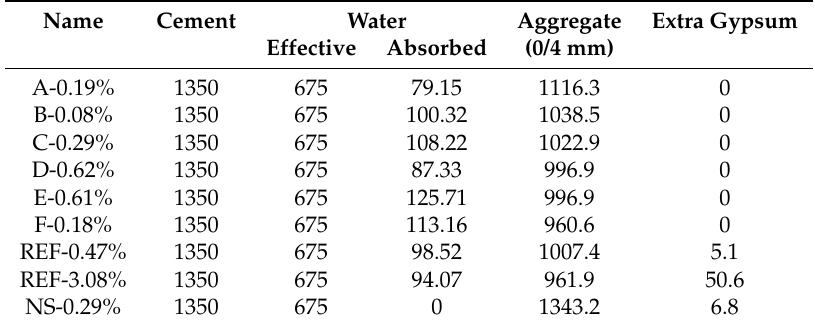
Table 3. Compositions, in g, of the mortars, using the values of the recomposed FRA from Table 2. The samples are named after the source of their FRA, and the water soluble sulfate content in their mix expressed as a mass % of the aggregate fraction. Name Cement Water Aggregate Extra